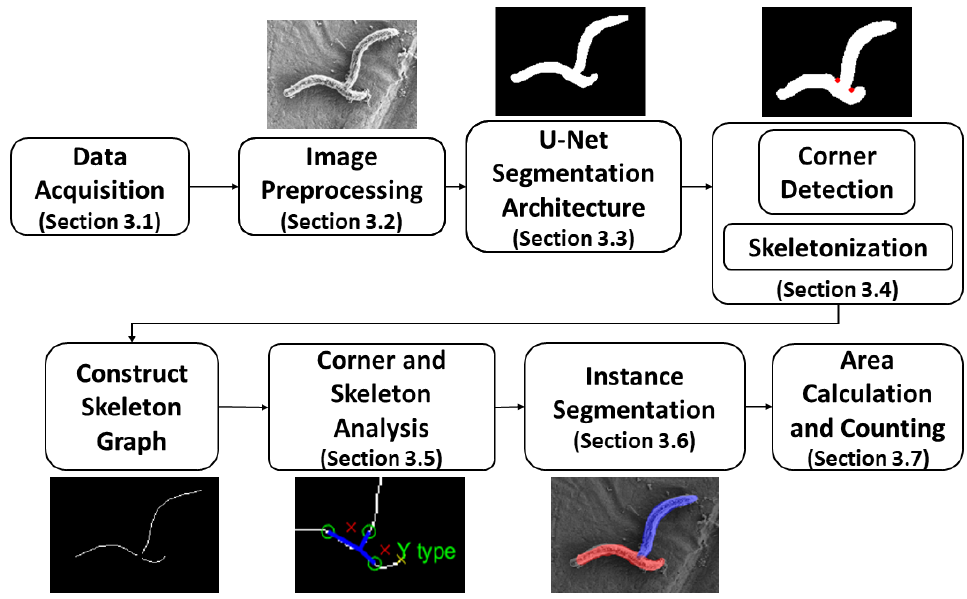
Figure 1. The flowchart of the proposed